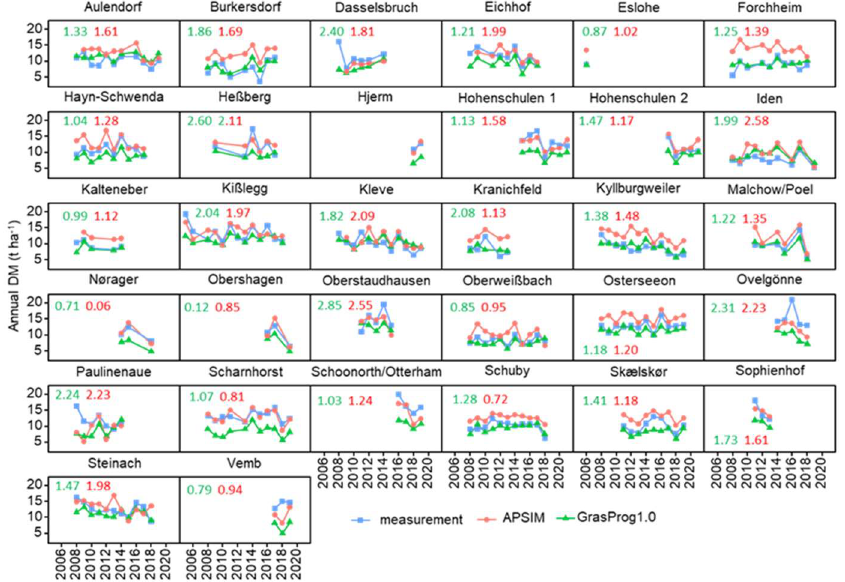
Figure 11. Annual measured grass dry matter (DM) and predictions by GrasProg1.0 and APSIM for different years for different locations in Germany and Denmark. The numbers show the RMSE for the two models (GrasProg1.0 green, APSIM red).